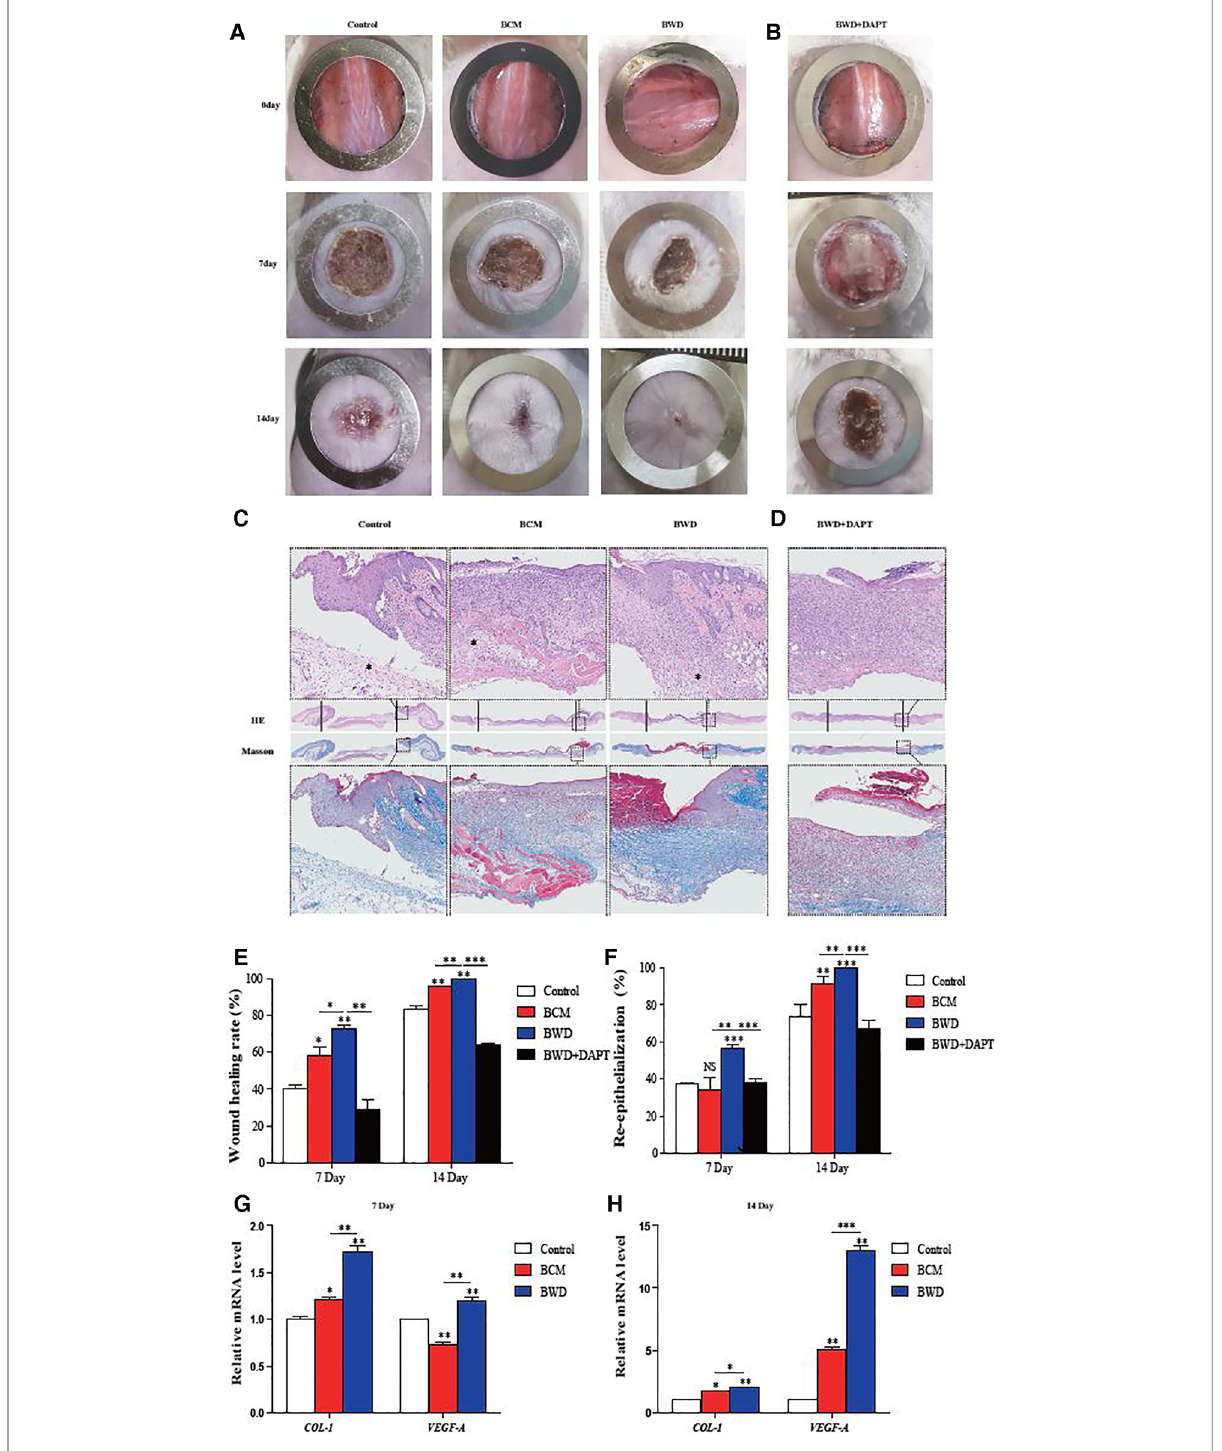
FIGURE 6 BWD promoted acute wound healing in mice. ( A ) Mouse wounds on days 0, 7, and 14 after the operation. ( B ) Mouse wounds collected on days 0, 7, and 14 after the operation, with DAPT as an inhibitor of the Notch signaling pathway. ( C ) Hematoxylin and eosin (HE) staining and Masson staining of the wound skin on day 7 (×40; * neovascularization). ( D ) HE staining and Masson staining of the wound skin on day 7, with DAPT as an inhibitor of the Notch signaling pathway (×40). ( E ) Analysis of the wound healing rate. ( F ) Statistical analysis of the epidermal gaps in each group. ( G,H ) Expressions of COL-1 and VEGF-A in the wound surface detected by qRT-PCR on days 7 and 14. Error bars represent SEM ( n =5), * P ≤ 0.05, ** P <0.01, and *** P ≤